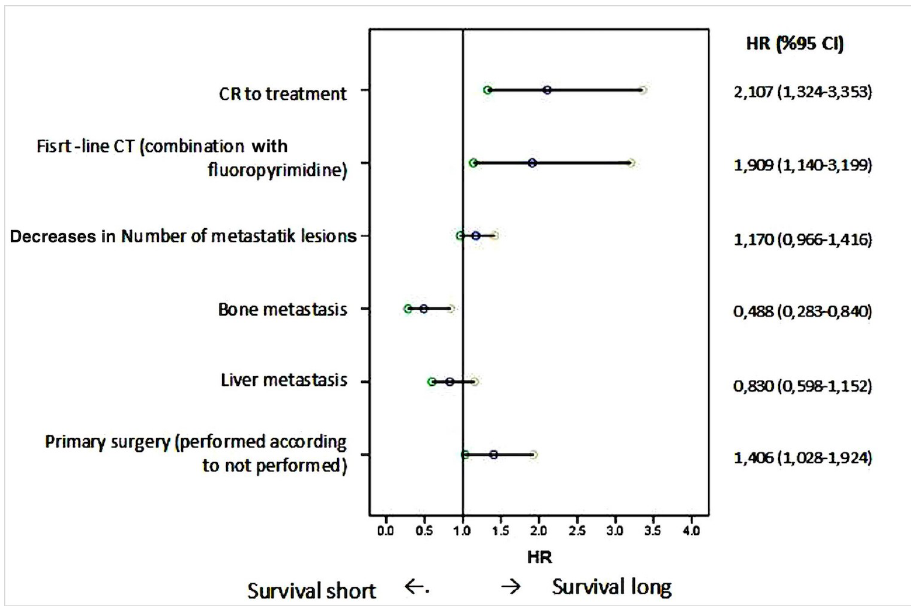
Fig 3. According to the multivariate analysis (logistic regression), the effects of variables on overall